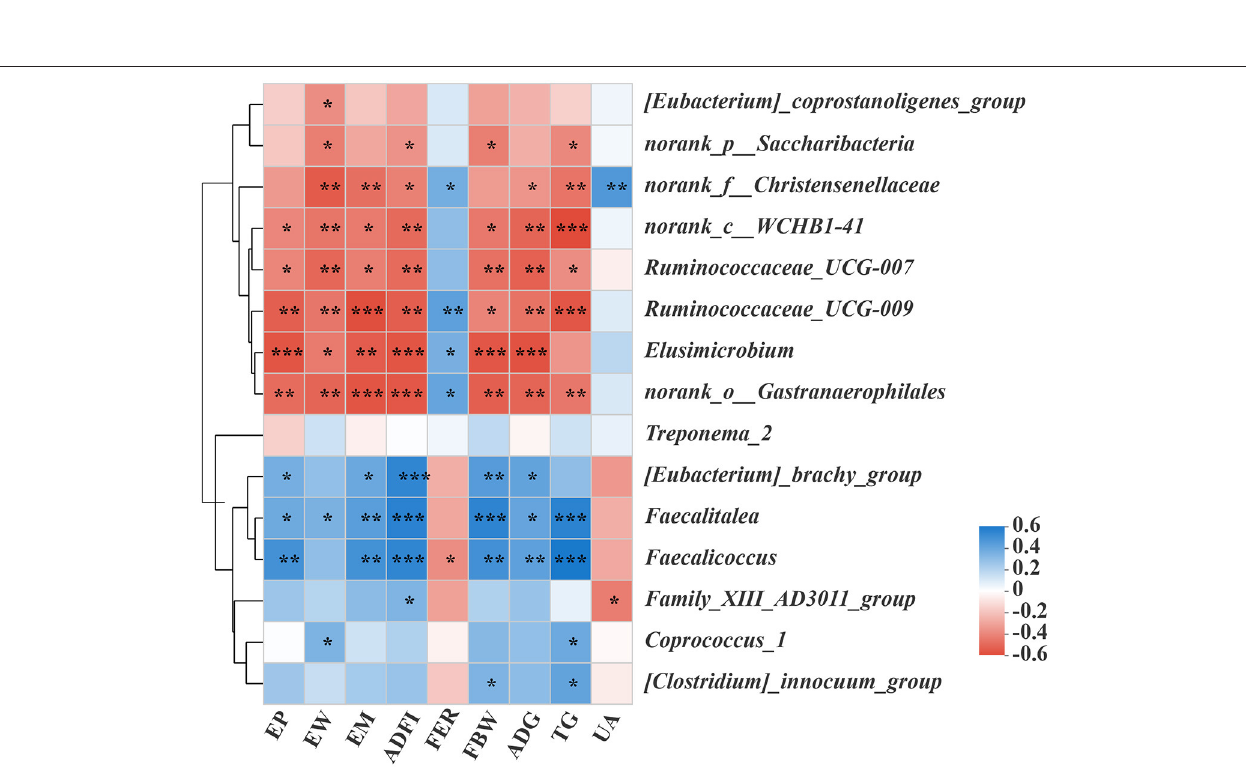
Frontiers in Nutrition |